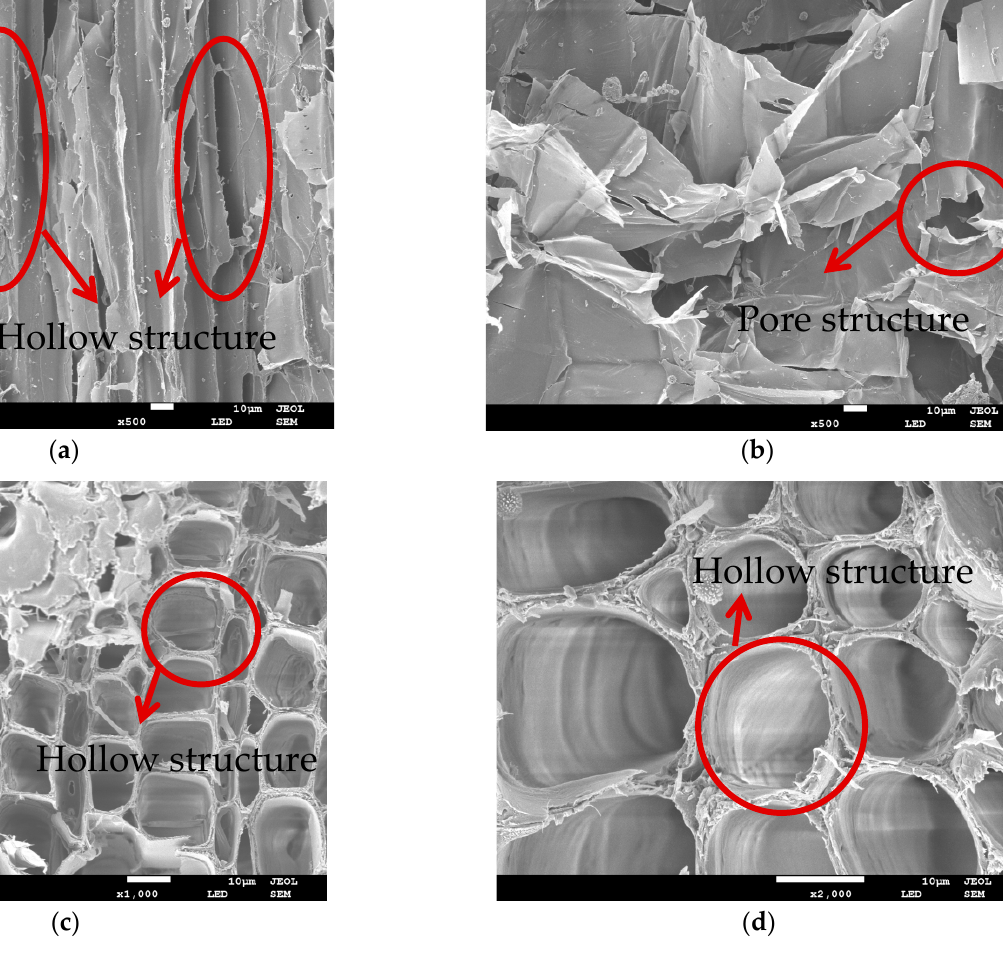
Figure 6. SEM of the morphological structure of hemp stalk. ( a ) Hollow structure of hemp stalk skin ×500 magnification; ( b ) Pore structure of hemp stalk core ×500 magnification; ( c ) Micromorphology of transverse section of hemp stalk ×500 magnification; ( d ) Micromorphology of transverse section of hemp stalk ×2000 magnification.